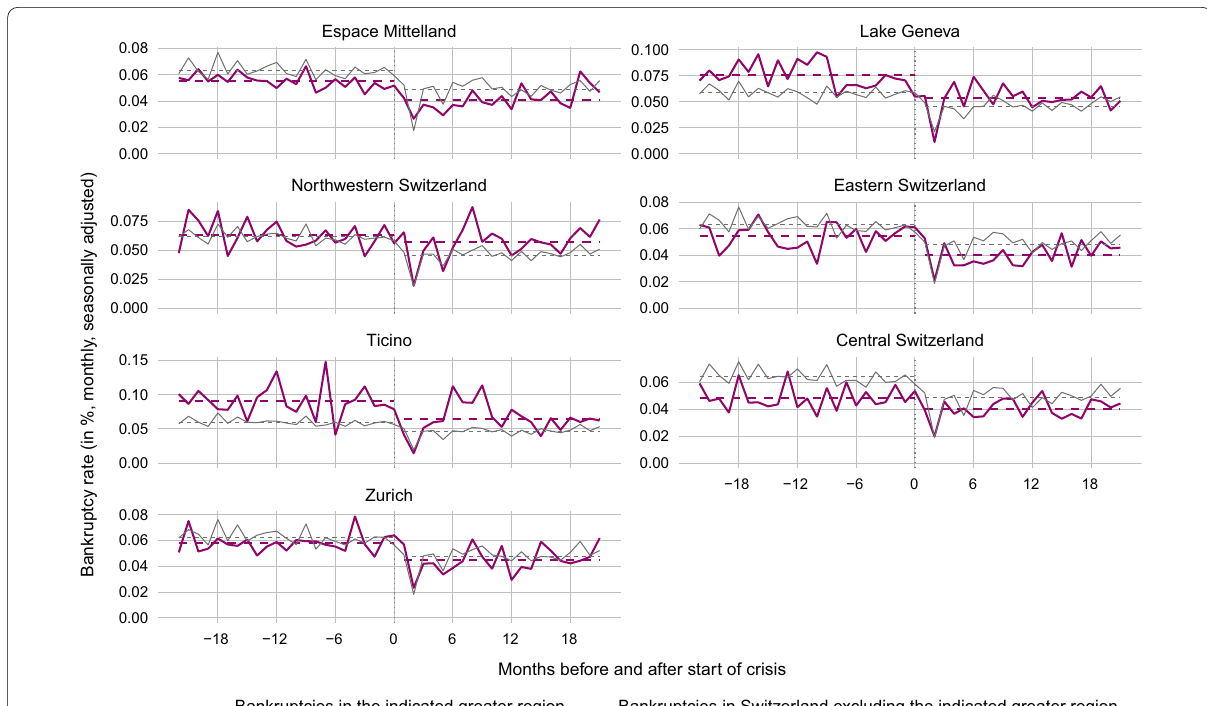
Fig. 10 Regional bankruptcy rates before and after start of COVID-19. Notes : The figure shows the monthly bankruptcy rate ( adjusted frequency of firm bankruptcies excluding SCO Art. 731b cases divided by the stock of firms) in the Swiss greater regions before and after the start of the COVID-19 crisis as compared to the bankruptcy rate in the respective rest of the economy. The last month before the crisis start ( month 0) is February 2020. The dotted lines are the average bankruptcy rates over the 22 months before or after the crisis